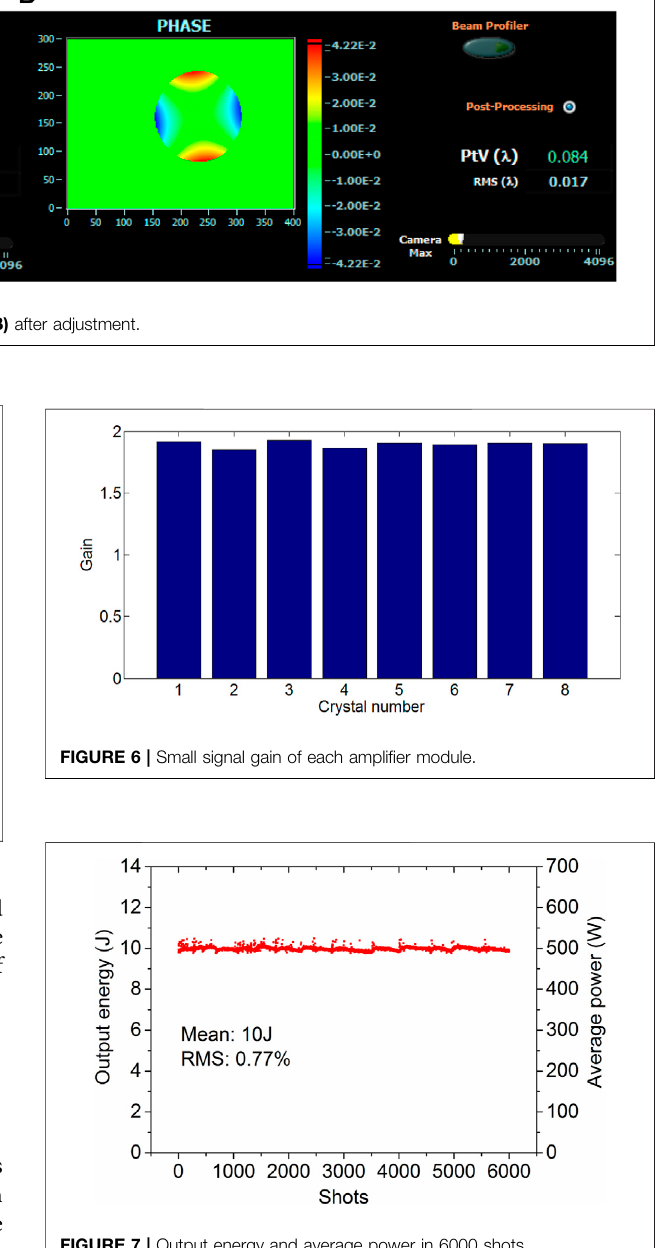
FIGURE 7 | Output energy and average power in 6000